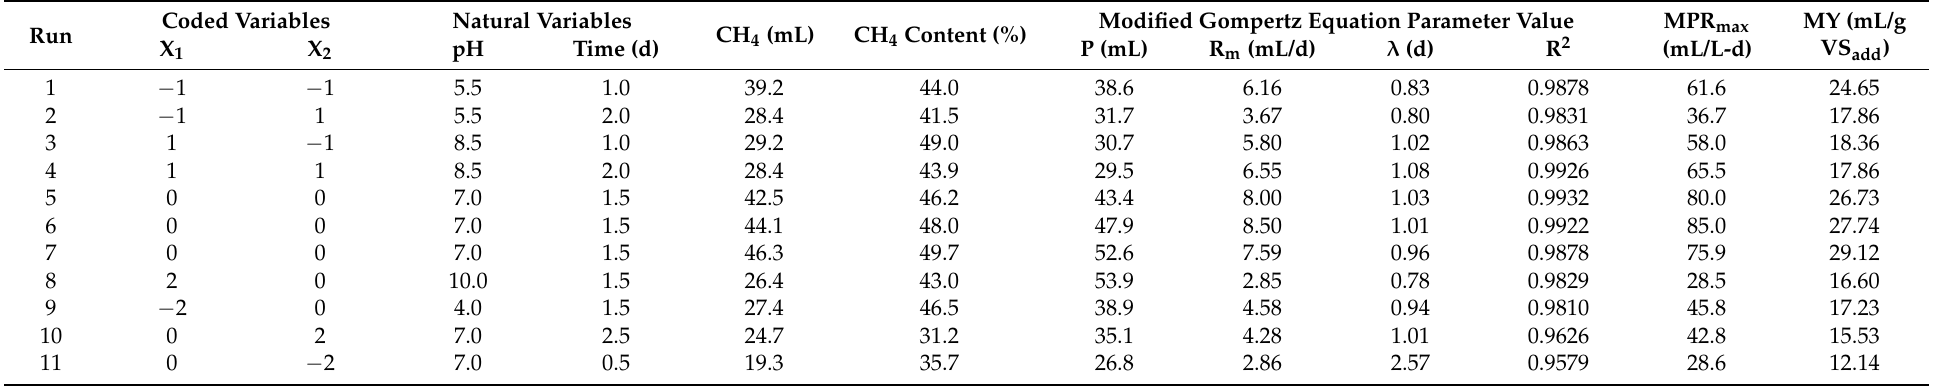
Table 2. Central composite design matrix of two variables in the coded and natural unit along with observed responses for optimizing the hydrolysis-acidogenesis stage.